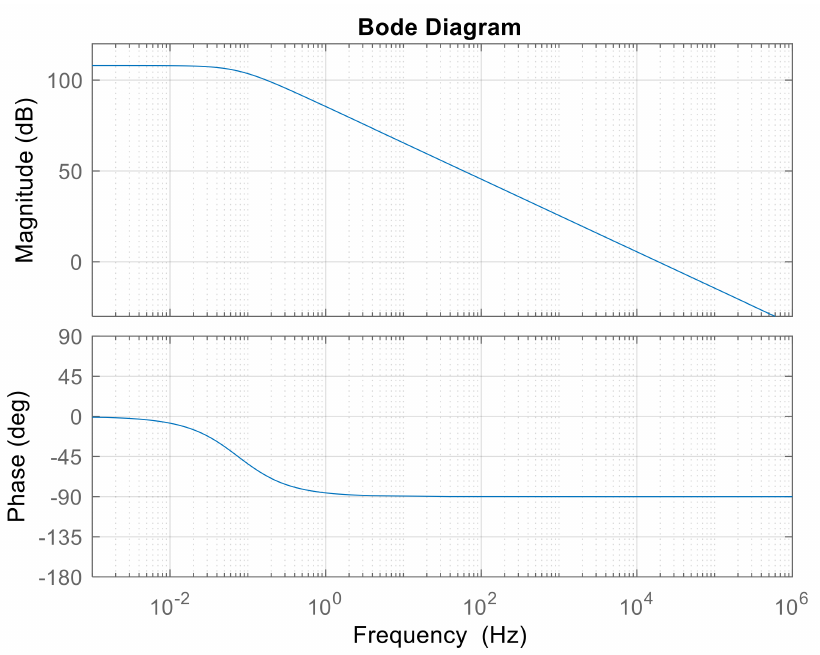
Figure A2. Bode plot of the open-loop transfer function G i ( s ). A horizontal line with an amplitude of 110 dB is a low-frequency asymptote, whereas a high-frequency asymptote is a straight line with a slope of –20 dB/decade. As illustrated in Figure A3, the intersection of these lines occurred at 0.0745 Hz.